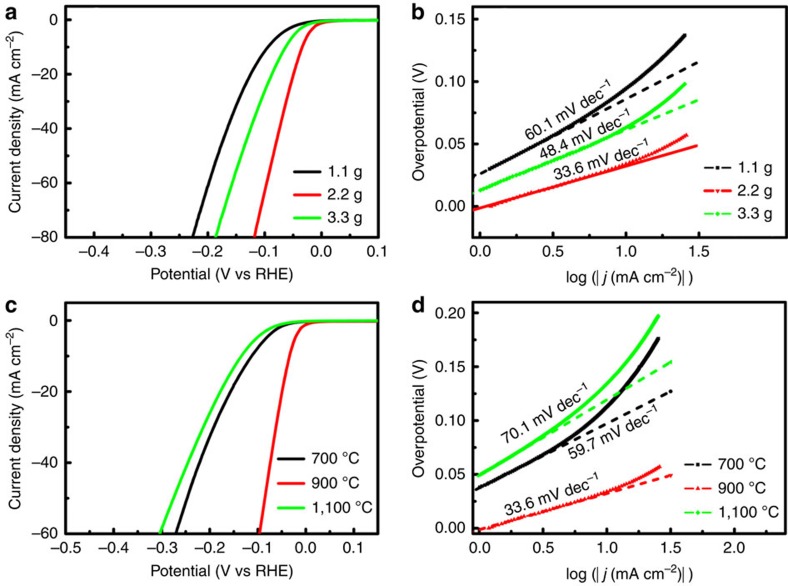
Comparison of the HER performance of different electrocatalysts.(a,b) Polarization curves and Tafe plots of Mo2C@NPC/NPRGO with different mass of PMo12 (1.1, 2.2 and 3.3 g). (c,d) Polarization curves and Tafe plots of Mo2C@NPC/NPRGO (2.2 g) at different carbonization temperature.